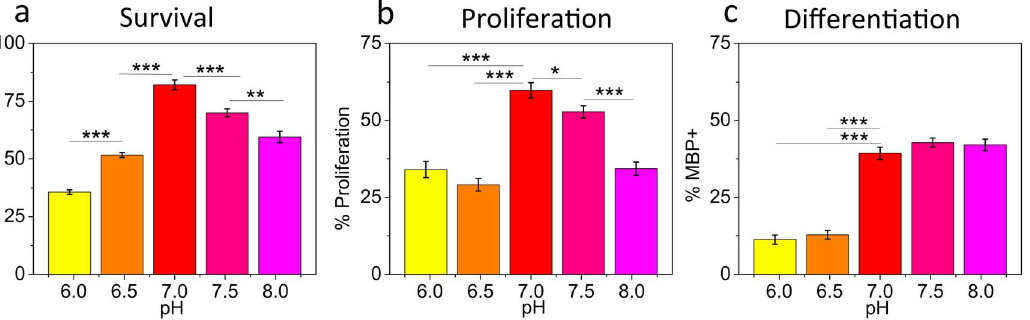
Figure 5. OPC survival, proliferation, and differentiation decrease in acidic extracellular pH (PDL surface, 50 m g/ml). ( a ) Survival was evaluated as percentage of live cells (detected with PI staining) relative to a total number of cells (detected via Hoechst staining). Data are from three (pH 6.0 and 6.5) or two (pH 7.0, 7.5, and 8.0) experiments. ( b ) Proliferation was evaluated by immunostaining against Ki67 protein and expressed as percentage of Ki67 positive cells with respect to a total number of cells. Data are mean for six (pH 6.0 and 6.5) or four (pH 7.0, 7.5, and 8.0) experiments. ( c ) Differentiation evaluated by immunostaning against myelin basic protein, MBP, and expressed as percentage of MBP-positive cells with respect to a total number of cells. Data are average for six (pH 6.0 and 6.5) or four (pH 7.0, 7.5, and 8.0) experiments. ( a–c ) Error bars are SEM; * p , 0.05, ** p , 0.01, *** p , 0.001. Colors correspond to cell media pH.